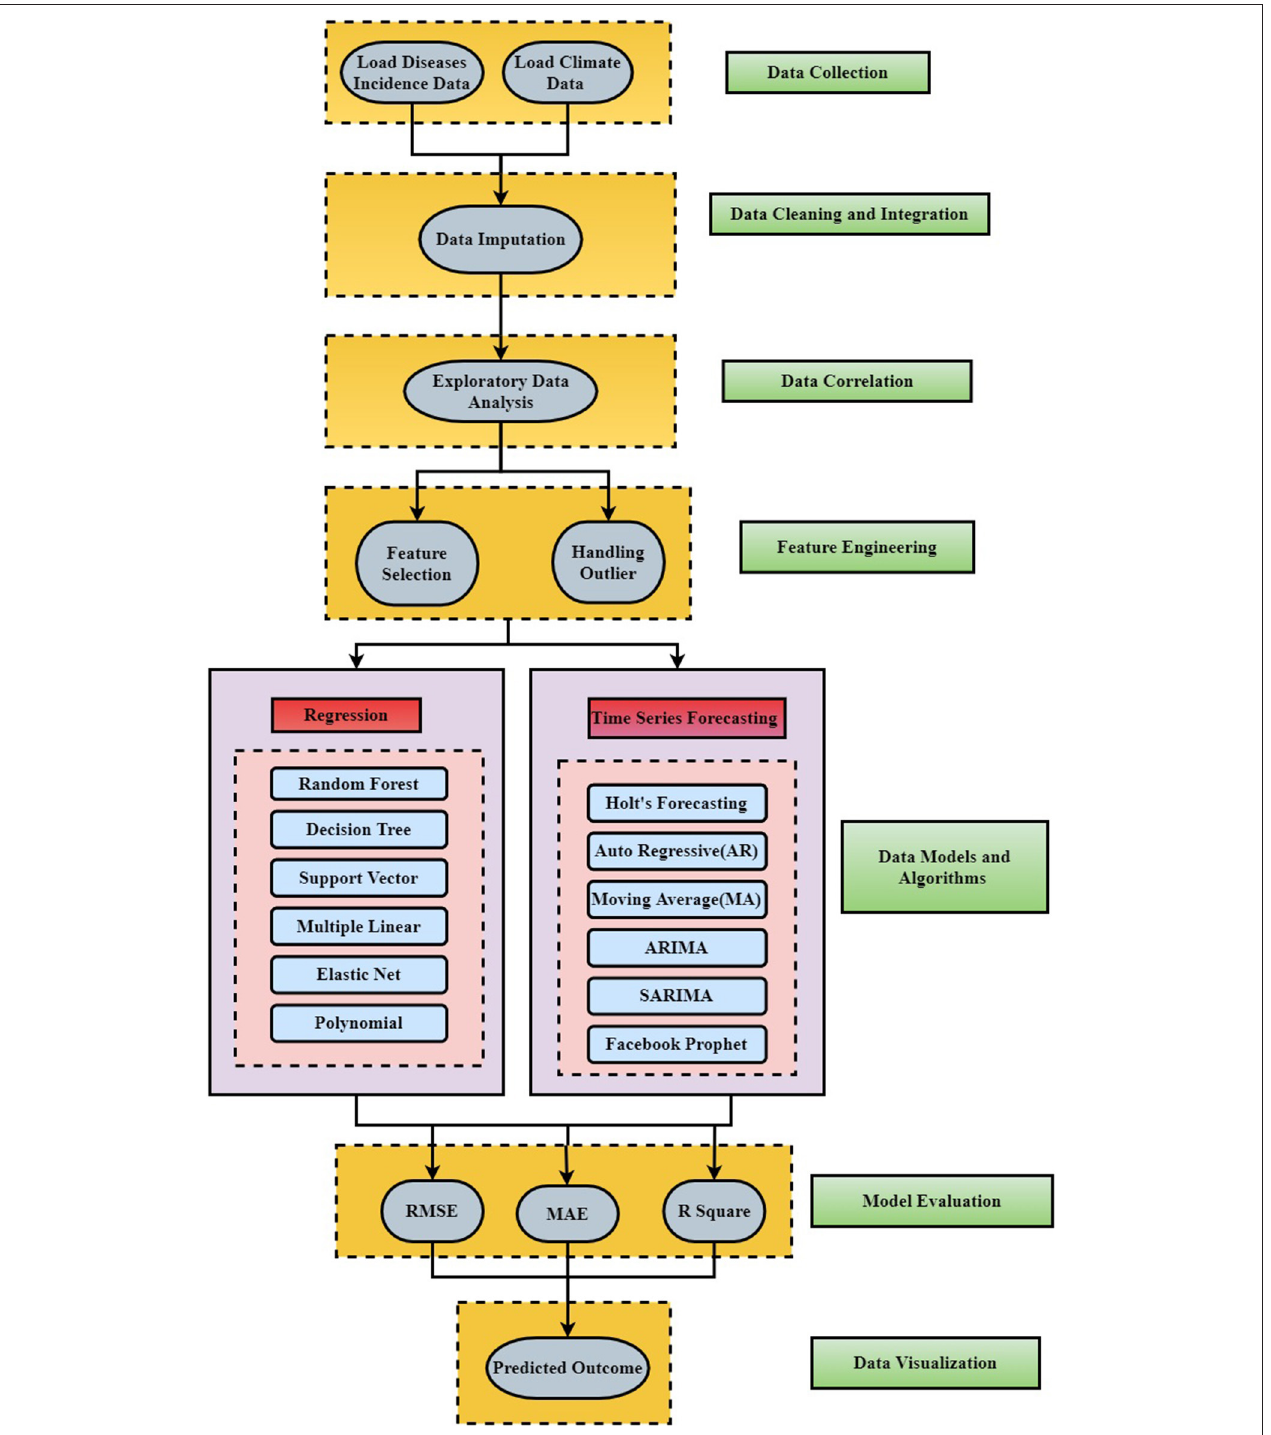
FIGURE 3 | Summarized flow diagram for the forecasting model.